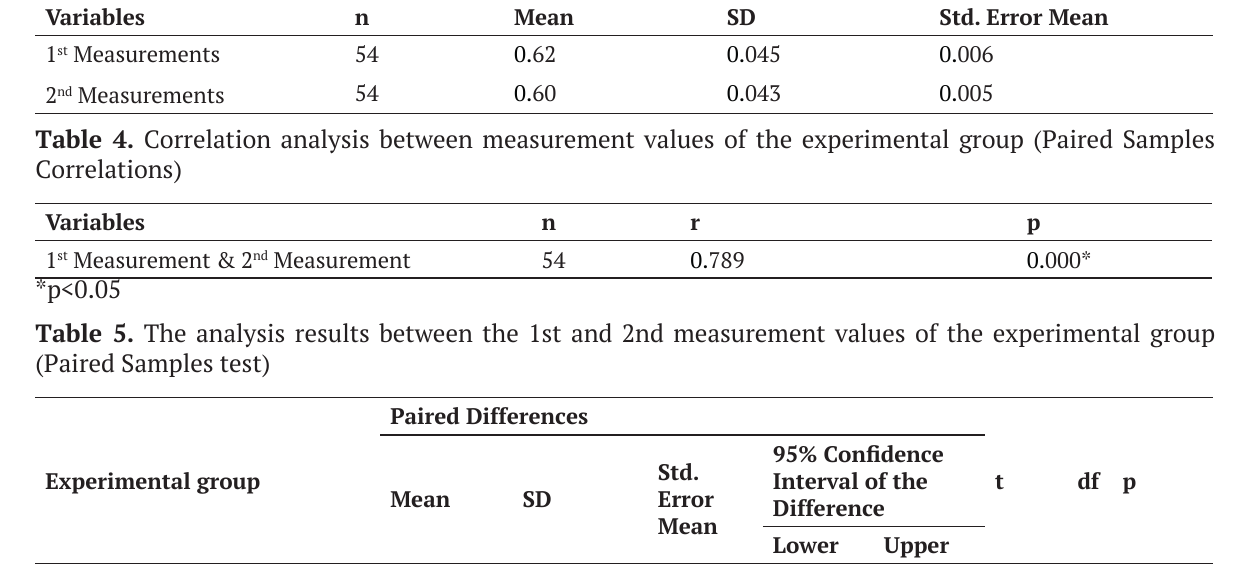
Experimental group